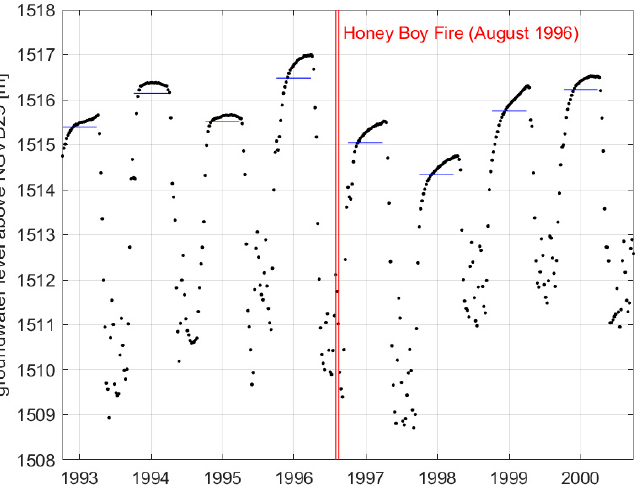
Figure 6. Weekly-averaged groundwater level in USGS well 382020112585901 for the study period of 1 October 1992 through 30 September 2000. The horizontal blue lines are groundwater levels averaged each winter from 1 October through 31 March.